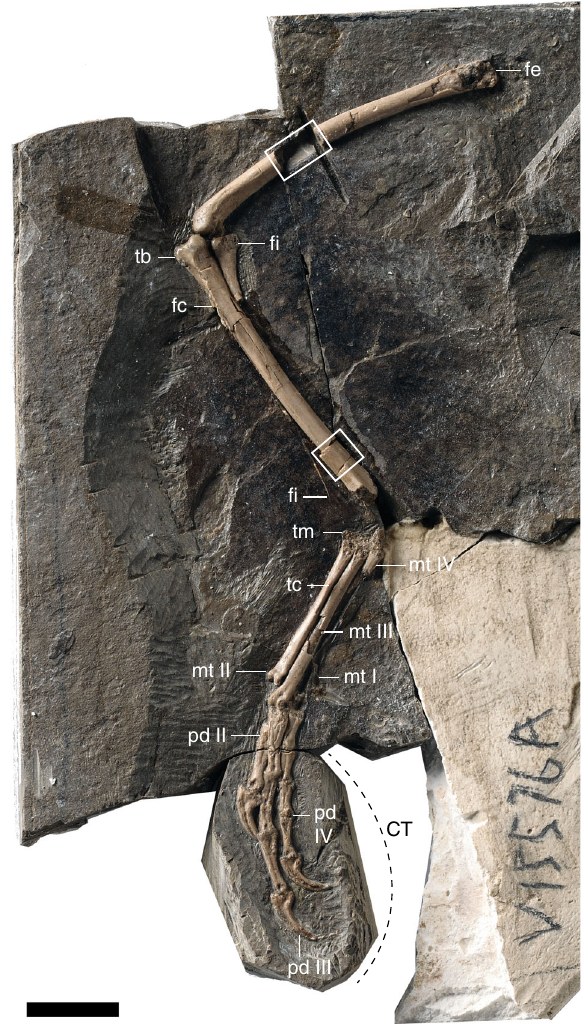
Fig. 1 Photograph of the main slab of Pengornithidae indet. (Aves: Enantiornithes) IVPP V15576A represented by a left hindlimb in lateral view. Scale bar equals 10 mm. Dashed line indicates portion of slab removed for CT scanning. Anatomical abbreviations: fc, fi bular crest; fe, femur; fi , fi bula; mt, metatarsal; pd, pedal digit; tc, area of attachment of the m. tibialis cranialis;